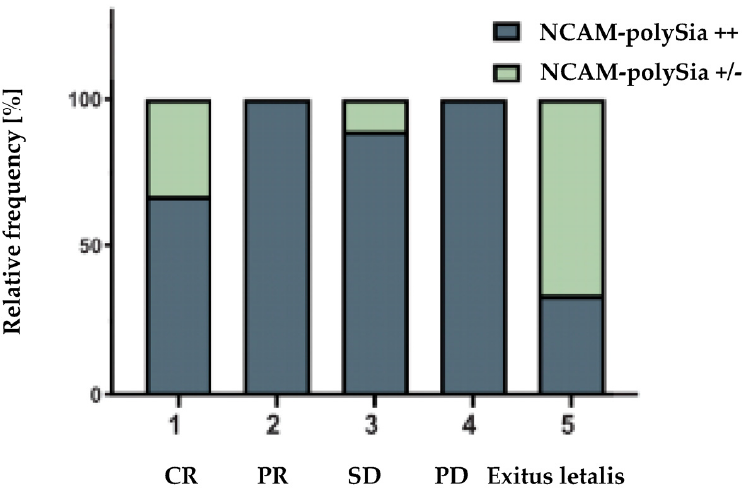
Figure 5. Evaluation of disease progression according to RECIST 1.1 criteria in comparison with the number of patients showing strong polySia-NCAM expression. Most patients had strong expression of polySia-NCAM (grey). While all patients were strongly positive in the category’s partial remission (abbr. PR) and progressive disease (abbr. PD), each patient showed no or only weak polySia-NCAM expression (green) in the category’s complete remission (abbr. CR) and stable disease (SD). In the three patients who died from the disease, only one patient was strongly polySia-NCAM pos- itive.